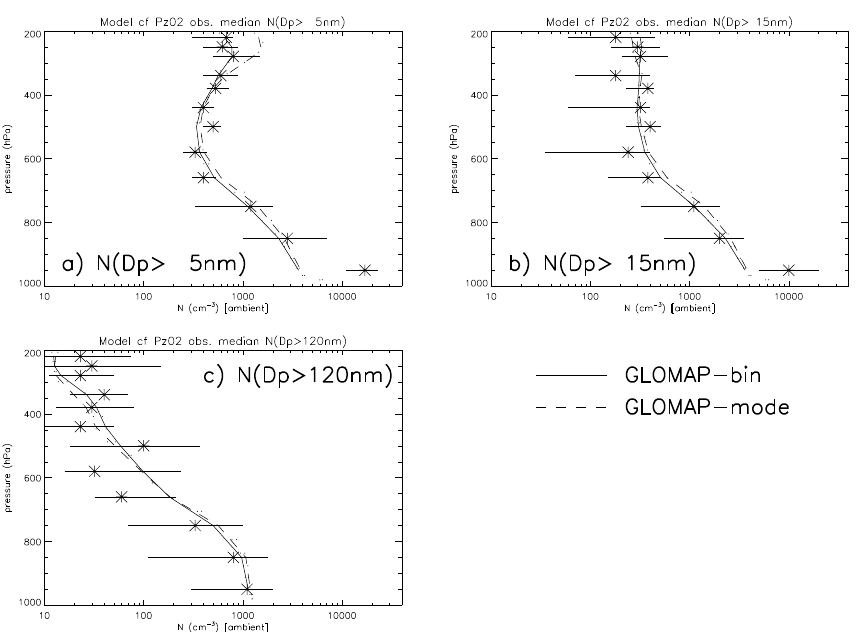
Fig. 15. Simulated vertical profiles of size-resolved number concentration compared to aircraft observations (Petzold et al., 2002) over NE Germany (13.5–14.5 ◦ E, 51.5–52.7 ◦ N) for particles larger than (a) 5nm, (b) 15nm and (c) 120nm dry diameter. Values of b and R are shown in Table 5 for each size-range from model values interpolated to a 1km grid to match the observations. The error-bars around the asterisks show the observed 25th and 75th percentiles in each 1km altitude range. The black lines show the August mean values for GLOMAP-bin (solid) and GLOMAP-mode v6R (dashed).